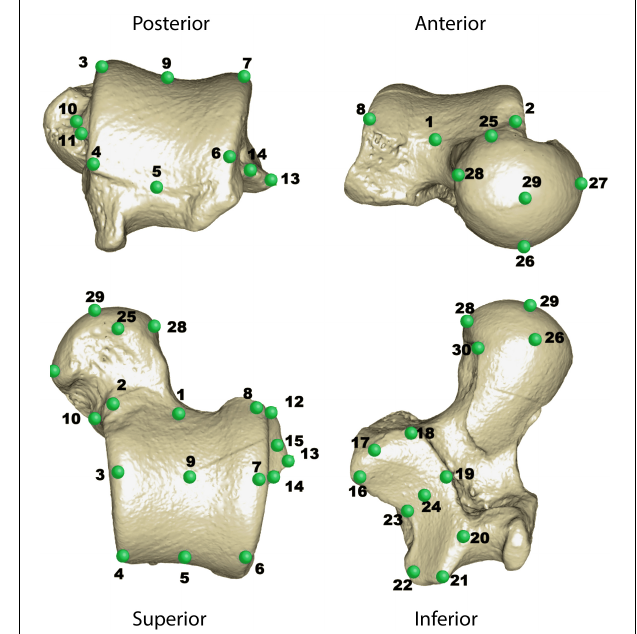
FIGURE 2 | A Chiropotes satanas talus (AMNH 95760) showing the 30 landmarks used in this